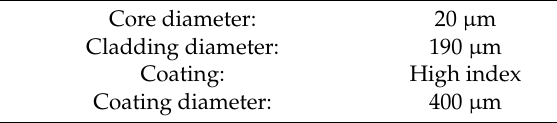
Table 5. Geometry parameters of the self-made single-clad [7].